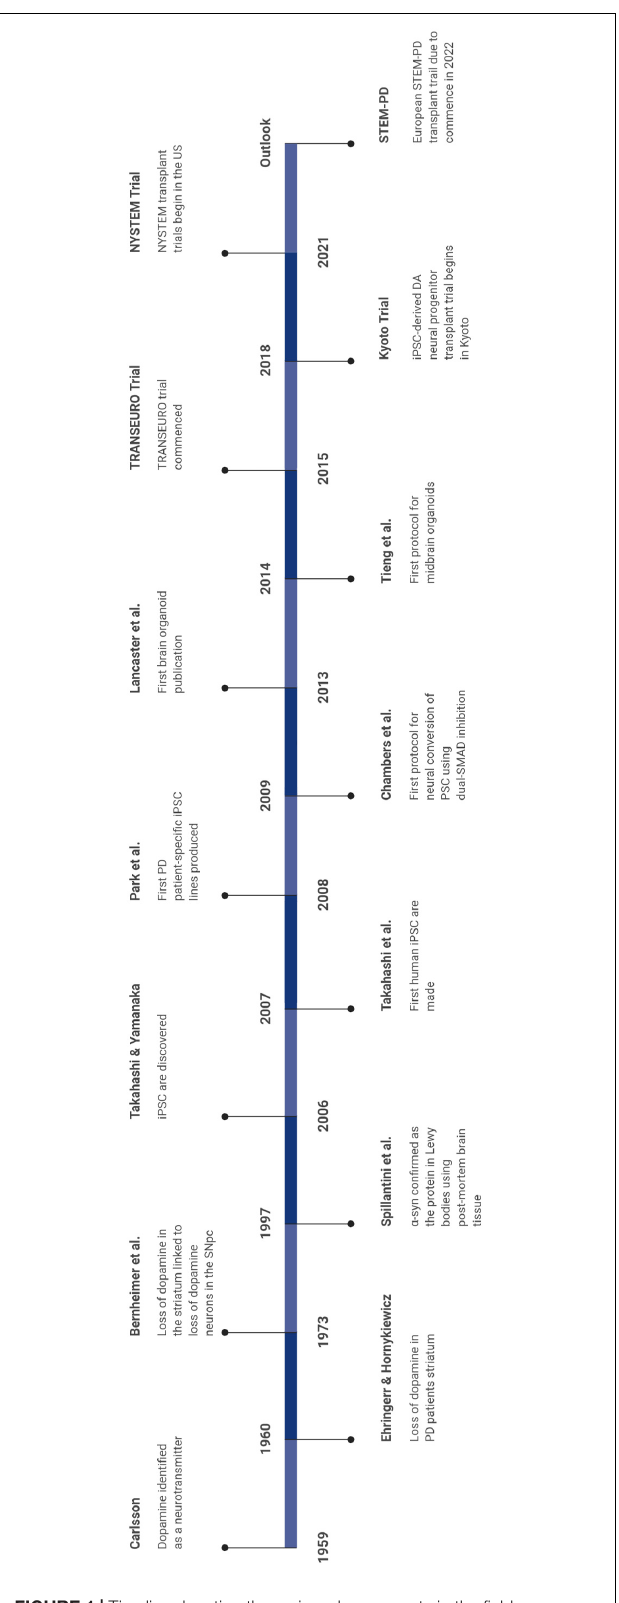
FIGURE 1 | Timeline denoting the major advancements in the